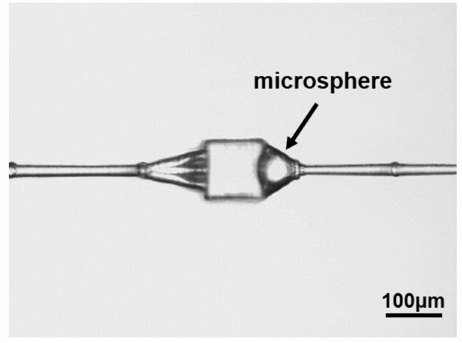
Figure 6. Improved simple microvalve